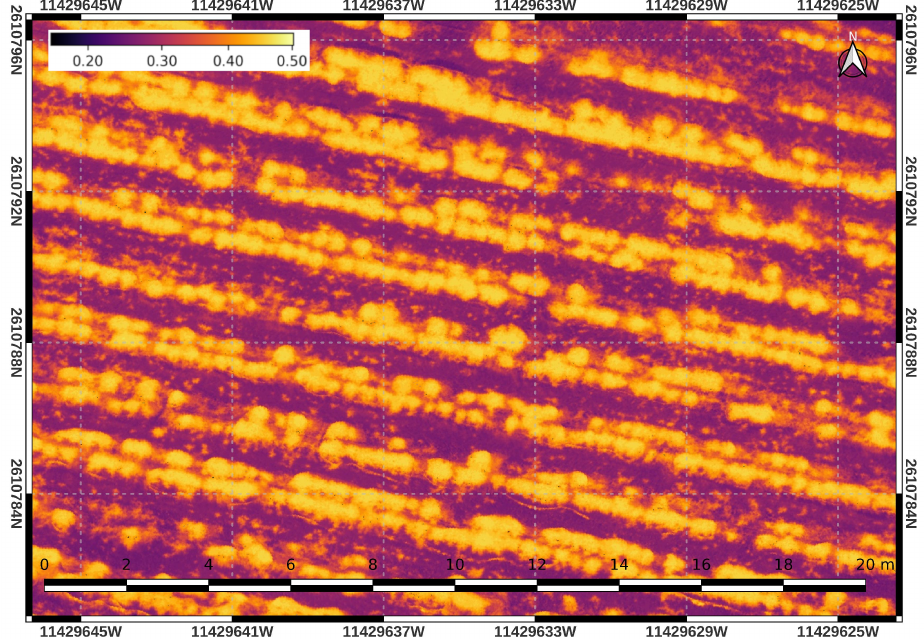
Figure 15. NDVI map at orthomosaic level